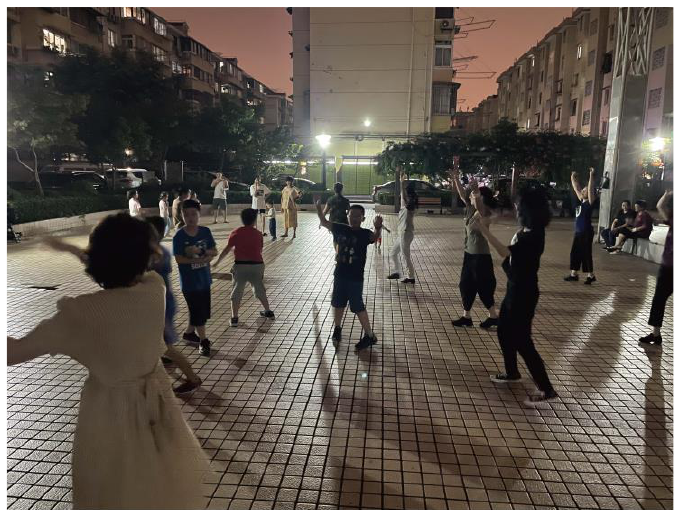
Figure 7. Older adults and children interacting in the square.